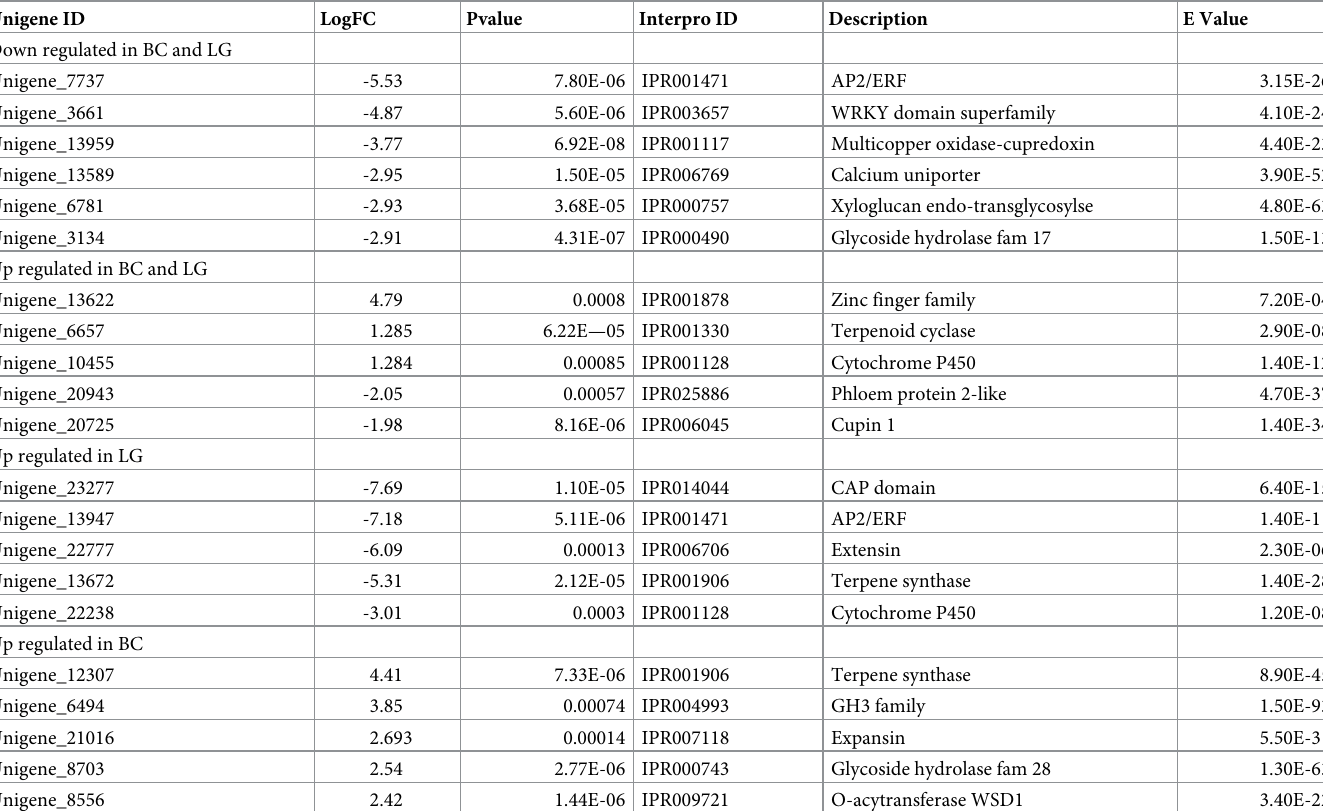
Table 3. Detail of the 21 differentially-expressed unigenes identified as having a potential role in regulating changes in post-harvest